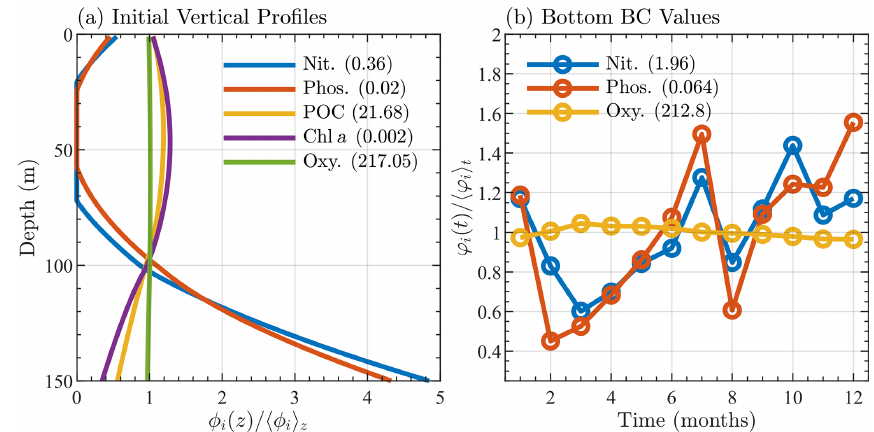
Figure 3. Sargasso Sea initial and boundary conditions showing (a) initial profiles of nitrate, phosphate, particulate organic carbon, chloro- phyll, and oxygen, where each profile, denoted φ i (z) , is normalized by its depth averaged value, (cid:104) φ i (cid:105) z , and (b) monthly bottom boundary conditions for nitrate, phosphate, and oxygen, where each quantity, ϕ i (t) , is normalized by its annual average value (cid:104) ϕ i (cid:105) t . The depth and annual averaged values are shown in parentheses in the legends of each panel. Units are mmolNm − 3 for nitrate, mmolPm − 3 for phosphate, mgCm − 3 for particulate organic carbon, mgChlm − 3 for chlorophyll, and mmolOm − 3 for